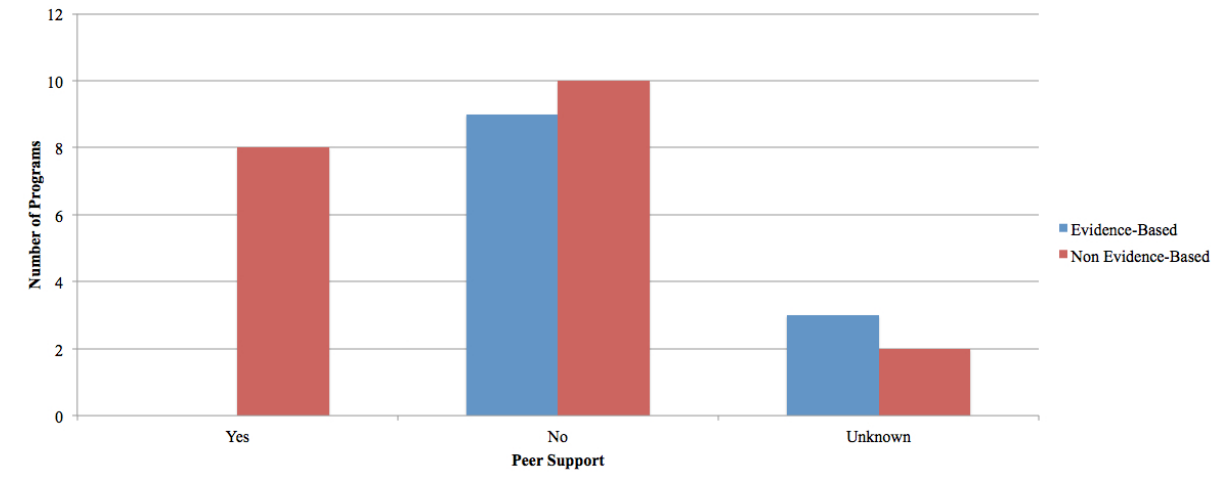
Figure 8. Support available from